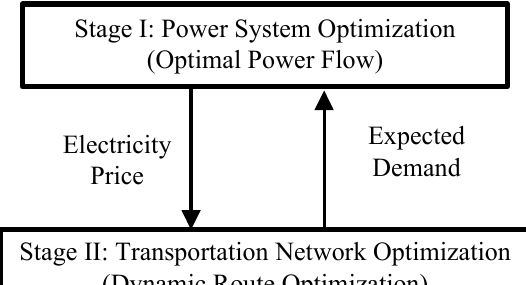
Figure 2. General two-stage optimization problem.